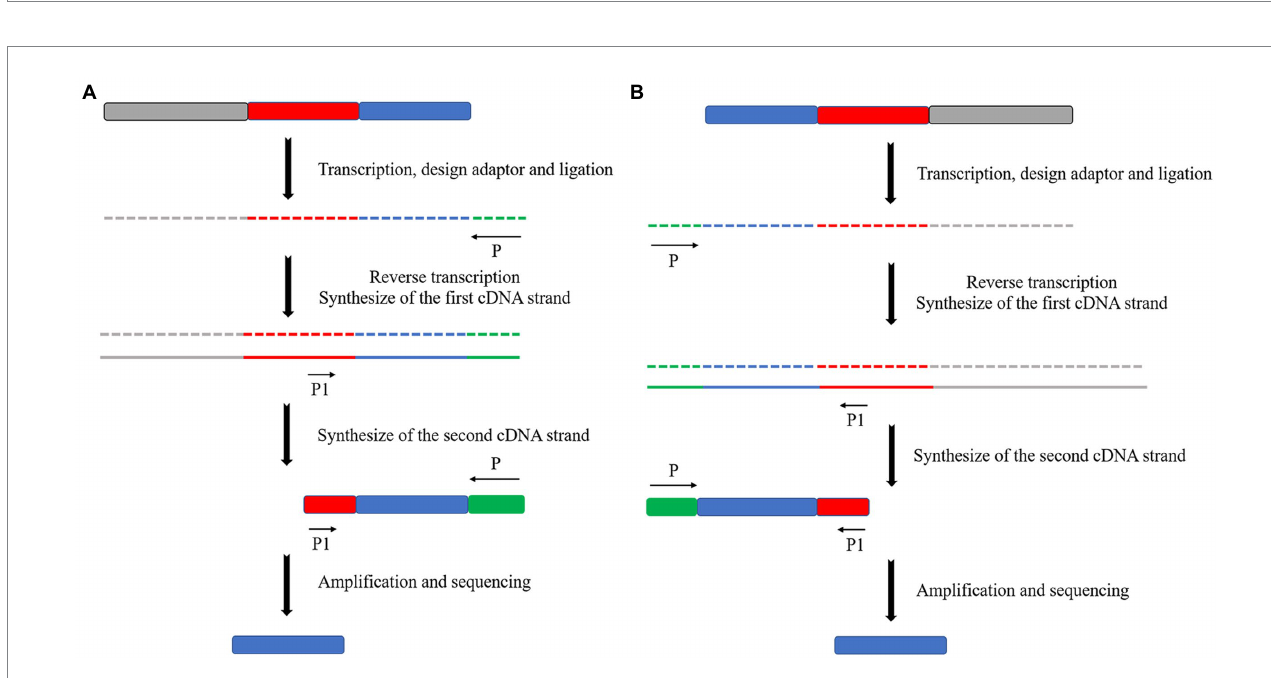
FIGURE 6 Schematic diagram of the principle of RACE in prokaryotes. (A) 3 ′ end RACE. (B) 5 ′ end